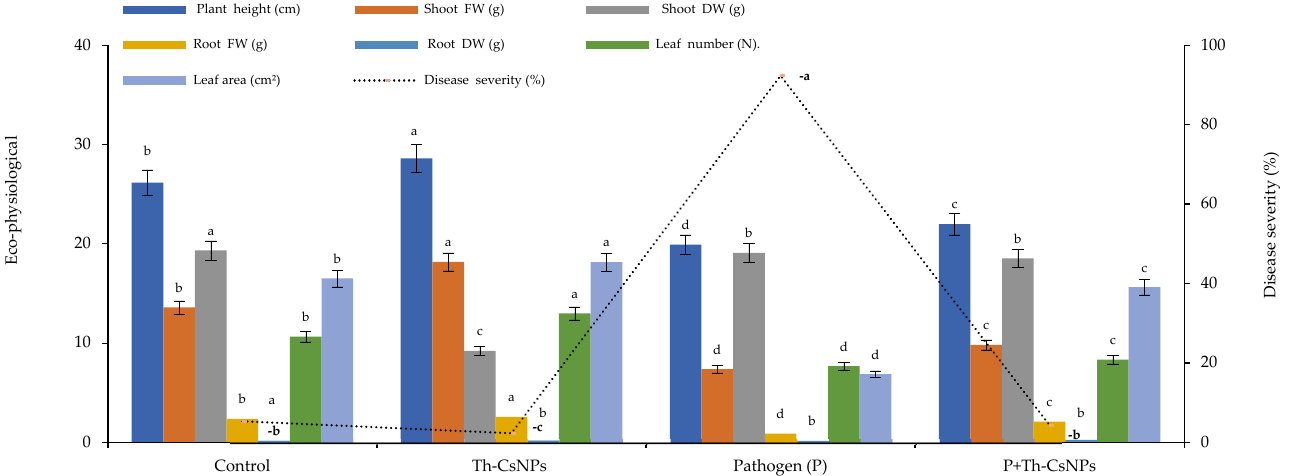
Figure 4. Effects of ThE-CsNPs on disease severity and eco-physiological parameters of S. lycopersicum seedlings. Bars with different letters indicate significant differences between treatments at p ≤ 0.05. Data are expressed as mean values of three replicates (±SDs).